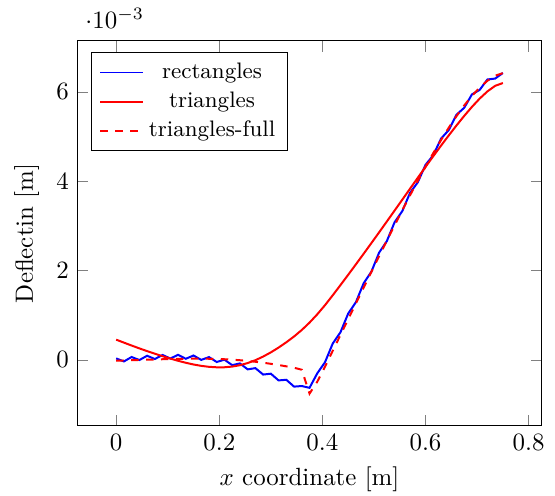
Figure 3. Deflection distribution on line { ( x, y ) | y = 0 . 75 } .